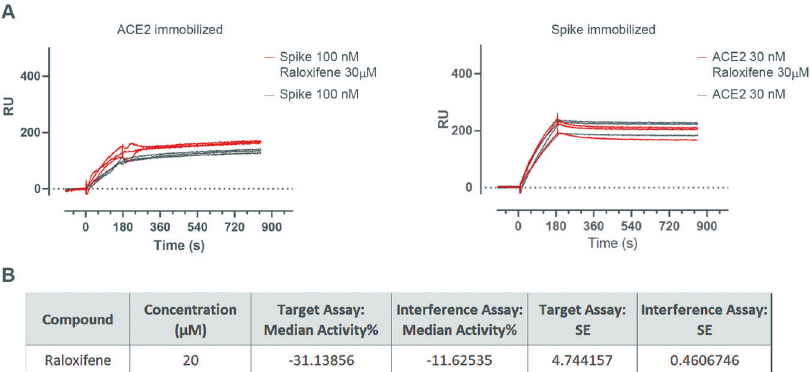
Fig. 5 Effect of raloxifene on ACE2-S protein interaction. A SPR experiments showed that raloxifene does not interfere with either S binding to immobilized ACE2 (left panel) or with ACE2 binding to immobilized S (right panel). Solutions were injected in triplicate; black lines show the sensorgrams with the proteins alone, while red lines show the sensorgrams with the proteins preincubated with raloxifene. B TR-FRET ACE2- SpikeS1 interaction assay showed that raloxifene is not able to interfere with the protein binding.